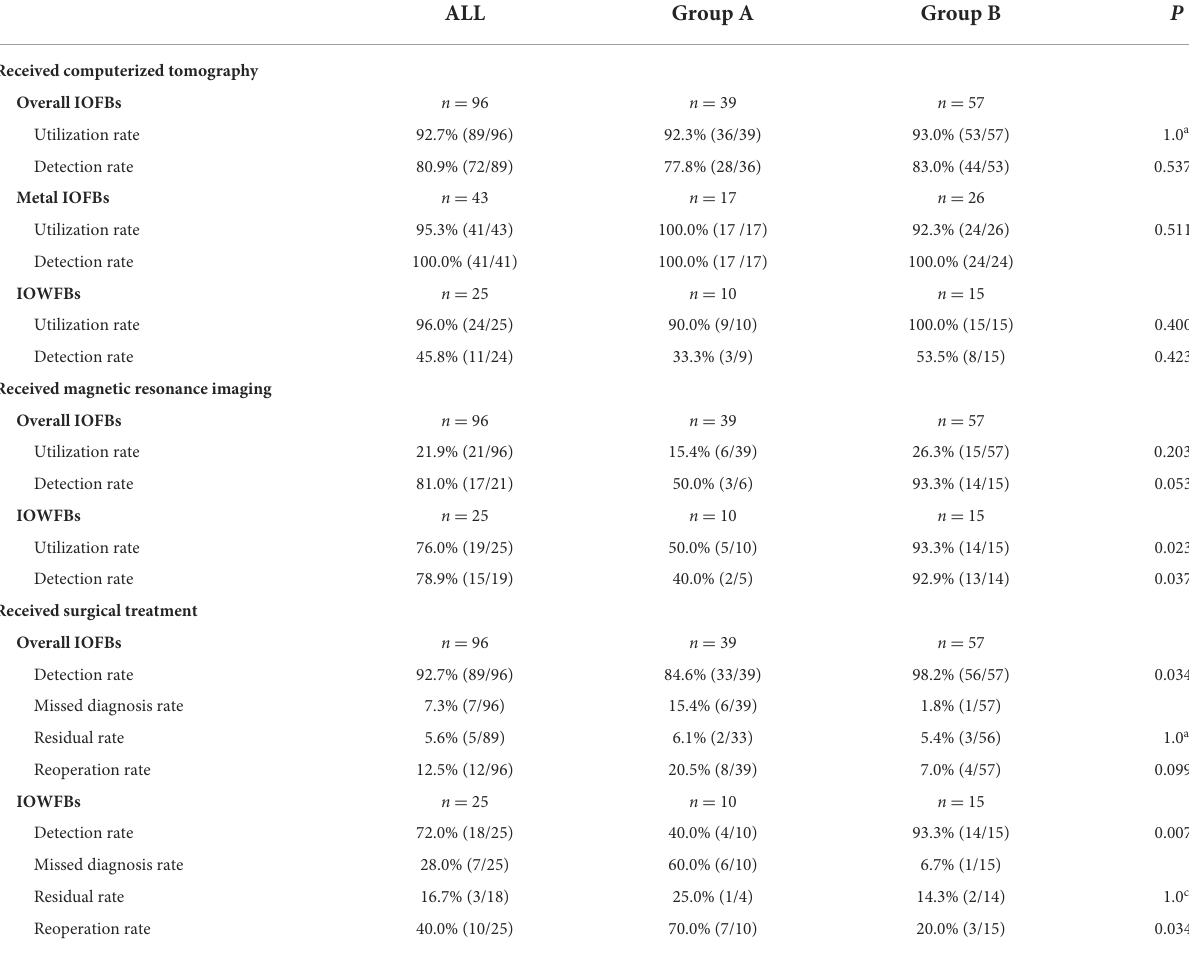
TABLE 2 The findings of imaging examination and surgery in patients with intraorbital foreign bodies.